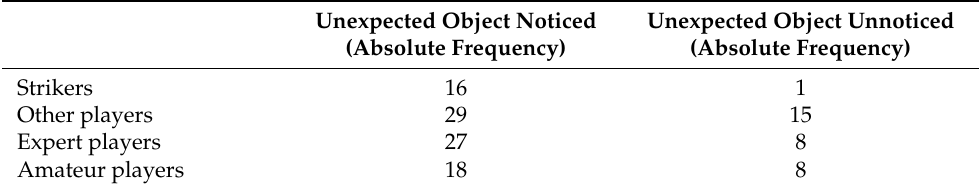
Table 1. Rates of noticing the unexpected object (absolute frequency) per group. Unexpected Object Noticed Unexpected Object (Absolute Frequency)